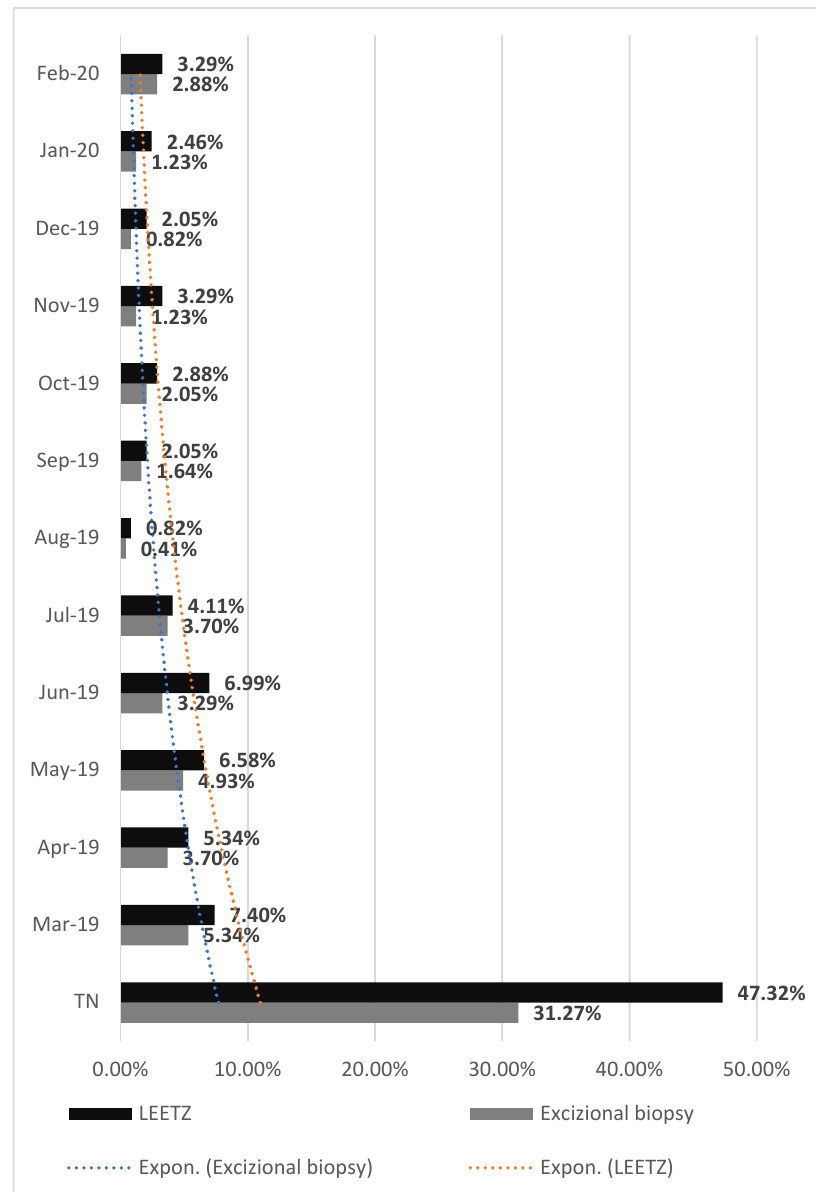
Figure 5. Surgical procedures performed in both clinics of the Emergency County Hospital in the year before the pandemic and the first year of the SARS-CoV-2 pandemic. OG: Obstetrics and Gy- necology Clinic. NPP: non-pandemic period; SP: first year of SARS-CoV-2 pandemic; LEETZ: Large loop excision of the transformation zone.